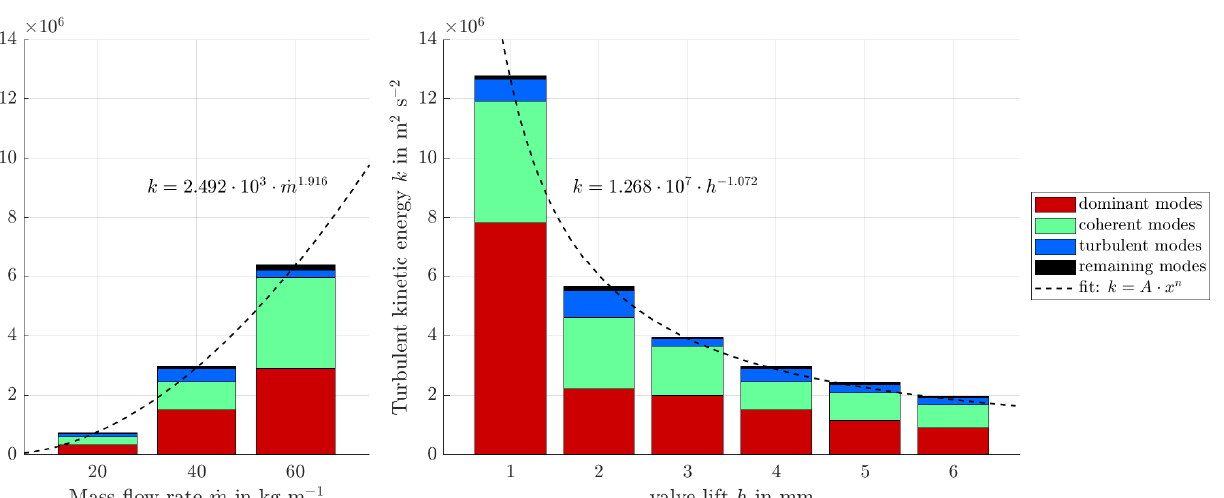
Figure 18. POD modes calculated from PIV measurements representing different flow structures at 4 mm and 39.6 kg/h.